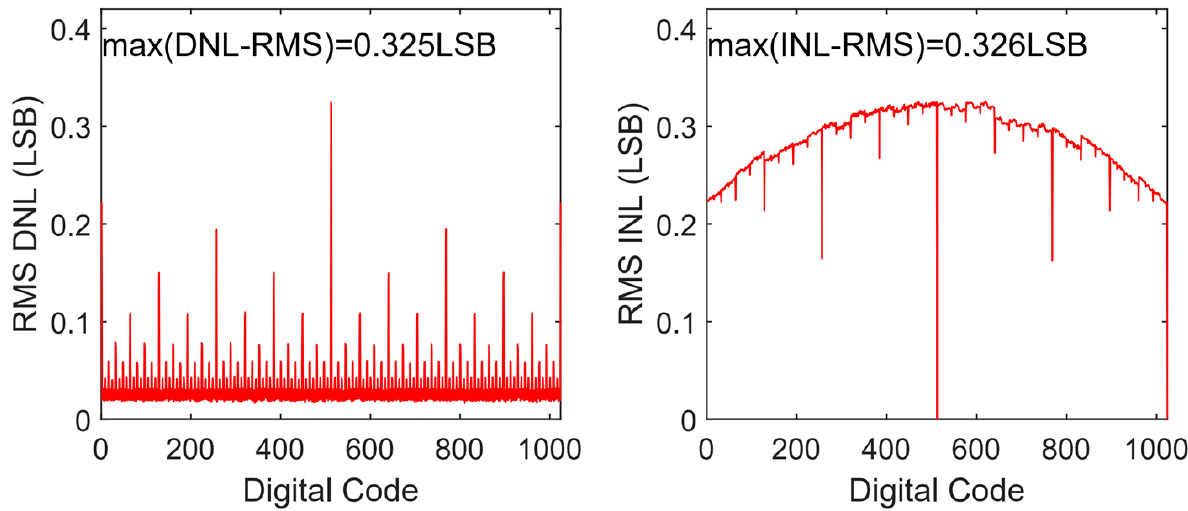
Figure 6. DNL and INL versus output code of the proposed switching scheme.